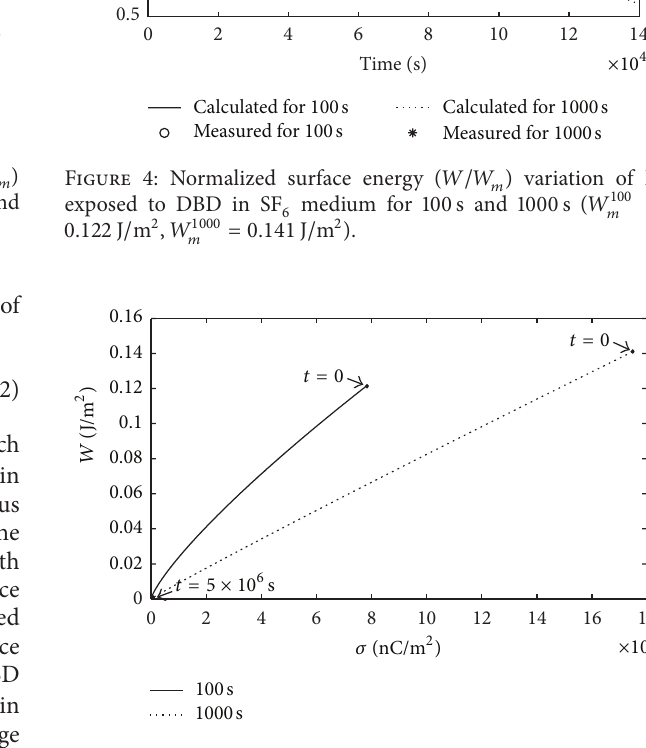
Figure 5: Variation of surface energy (𝑊) versus surface charge density (𝜎) in the decay time of 0 – 5 ⋅ 10 6 s for PI sample exposed to DBD in SF 6 medium for 100 s and 1000s (at 𝑡 = 0 , 𝑊 100 𝑚 = = 0.141 J/m 2 ; 𝜎 100 = 7.86 ⋅ 10 4 nC/m 2 ; 𝜎 1000 = 0.122 J/m 2 , 𝑊 1000 𝑚 𝑚 𝑚 17.47 ⋅ 10 4 nC/m 2 ).